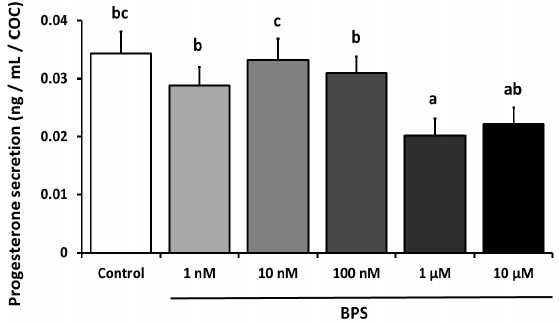
Figure 4. Effect of Bisphenol S (BPS) on progesterone secretion by cumulus oocyte complex (COCs) after 24 h in vitro maturation (IVM). COCs underwent IVM for 24 h in the presence or absence of BPS (1 nM, 10 nM, 100 nM, 1 µM or 10 µM). The progesterone concentration was measured in IVM media, and its value was normalised by the number of COCs in each well. Data are expressed as ng progesterone secreted per COC. The results of six independent experiments are presented as mean ± SEM. Bars with different superscripts indicate significant difference ( p ≤ 0.05).